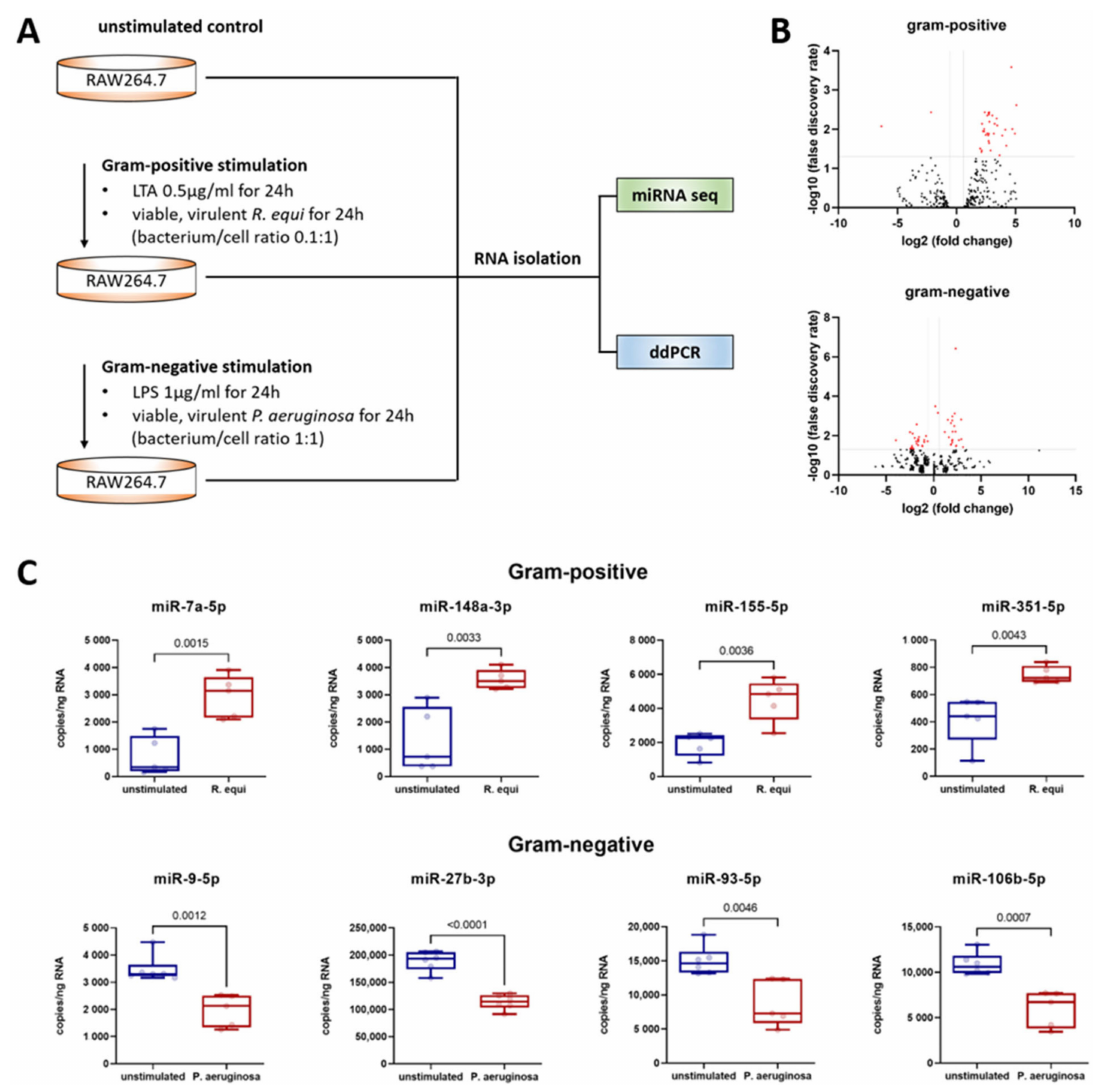
Figure 1. Murine macrophages (cell line RAW264.7, ATCC ® number TIB-71) were evaluated fol- lowing Gram-positive or -negative stimulation for 24 h and compared to unstimulated controls. ( A ) Workflow showing the cell culture conditions for miRNA sequencing and ddPCR. ( B ) Volcano plots showing the distribution of the fold changes and false discovery rates of all annotated miRNAs in a comparison between unstimulated and stimulated macrophages. For stimulation, either LTA (Gram-positive setting) or LPS (Gram-negative setting) was used. Red points above the horizontal line mark significant miRNAs (FDR > 0.05). The vertical lines mark the effect size threshold used. ( C ) Absolute miRNA quantification was performed by ddPCR analysis of isolated total RNA utilizing a QX200 Droplet Digital PCR System (Bio-Rad) and specific LNA PCR primers (Qiagen). The copy number of the target RNA in the total mixture was calculated by the system based on the number of positive droplets measured and assuming a Poisson distribution. In each ddPCR assay, a specific amount of RNA was used so that the copy number per ng of RNA can be calculated. The jittered box plots depict the median, the lower and upper quantile, the two extreme values, and the individual sample’s data points. Each group included five to six biological replicates and two technical replicates. Significant differences were identified utilizing an unpaired t -test. Statistical analysis was performed using GraphPad Prism 9 (GaphPad Software, La Jolla, CA, USA). A p -value < 0.05 was assumed to indicate significant differences. The p -values are specified in each